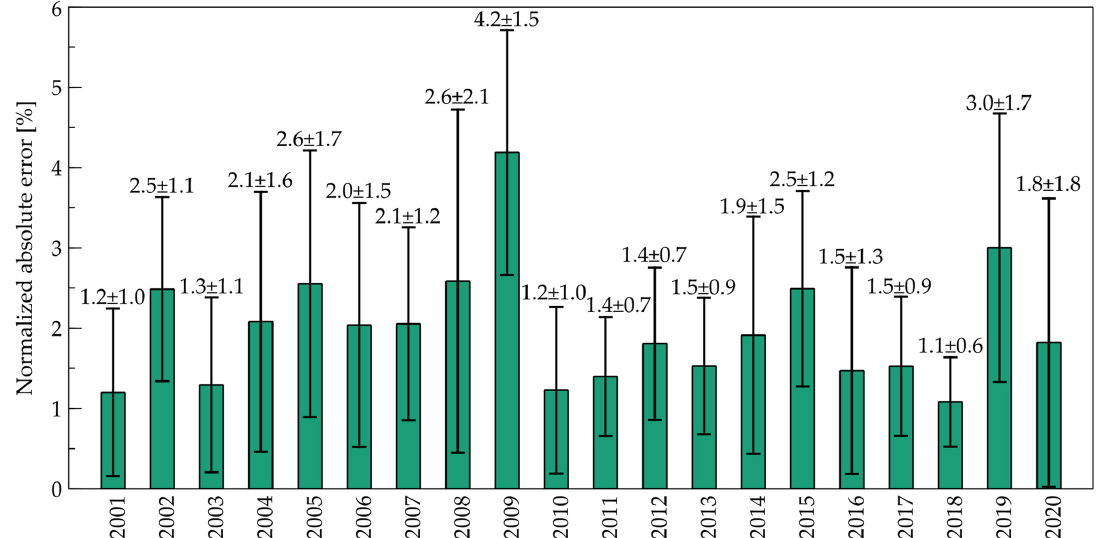
Figure 3. Normalized mean absolute errors of produced electricity on different weather summarization. Figure 4 further indicates that the use of real year from historic period produces al- most the same e ff ect of TMY on electricity production. The years 2001, 2003, 2020, and 2018, TMY and TMY Sandia have errors within the same order of magnitude and can be considered good representatives for the entire period.